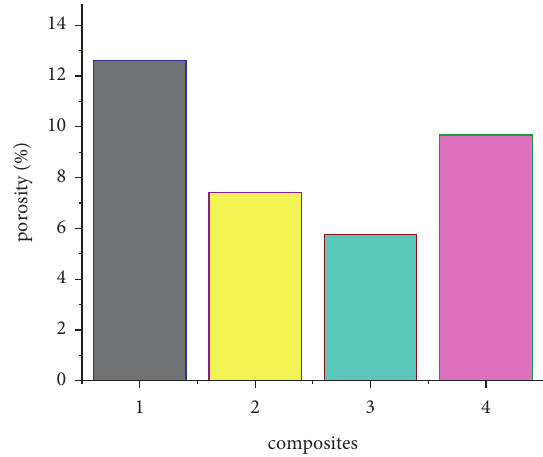
Figure 2: Percentage of porosity for the developed